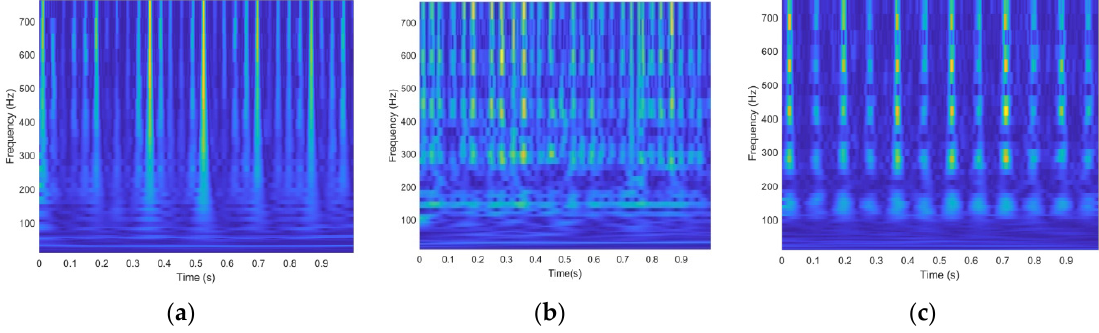
Figure 9. The 2-D representation for the ( a ) inner fault, ( b ) outer fault, and ( c ) roller fault.